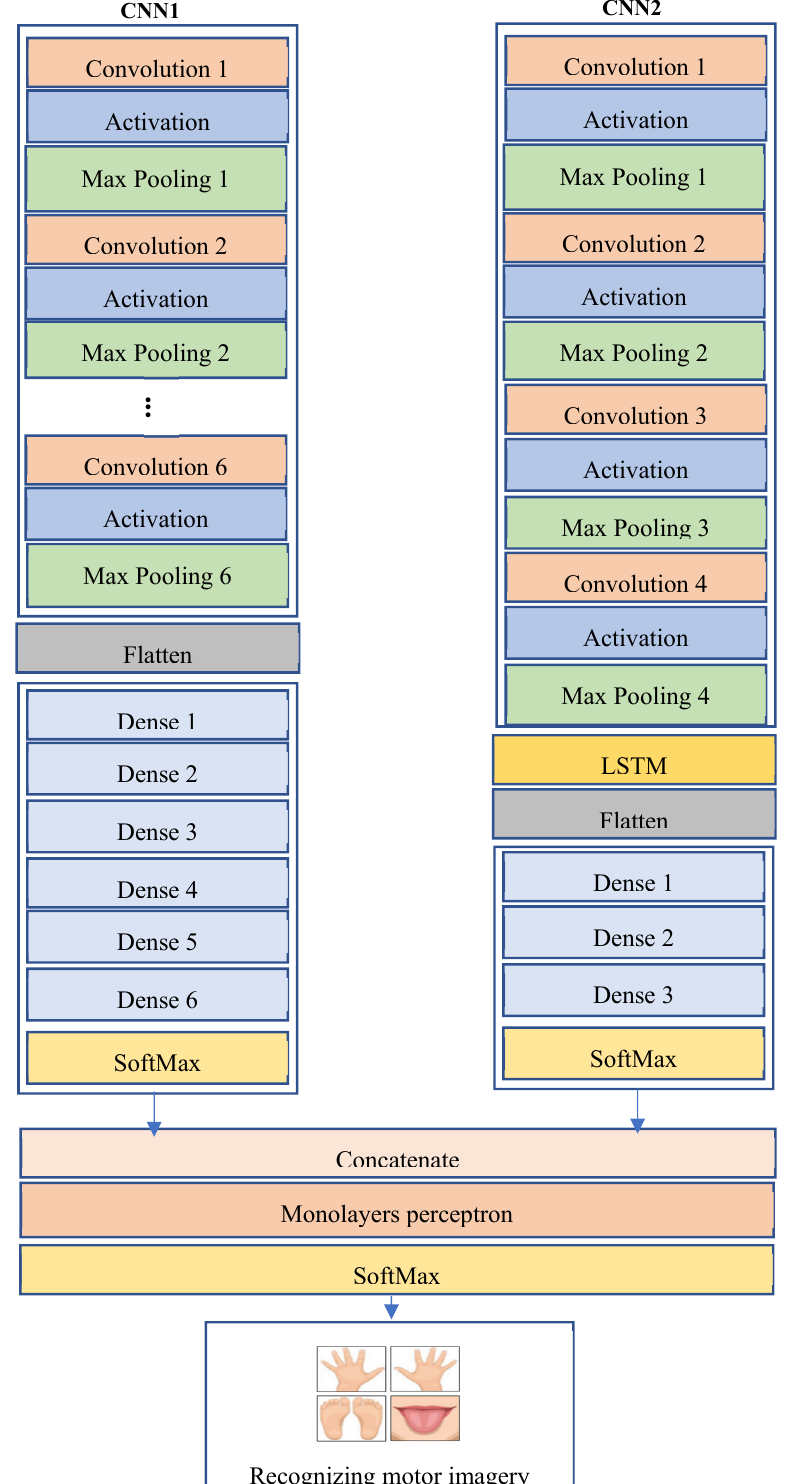
Figure 8. The proposed merged CNNs model.